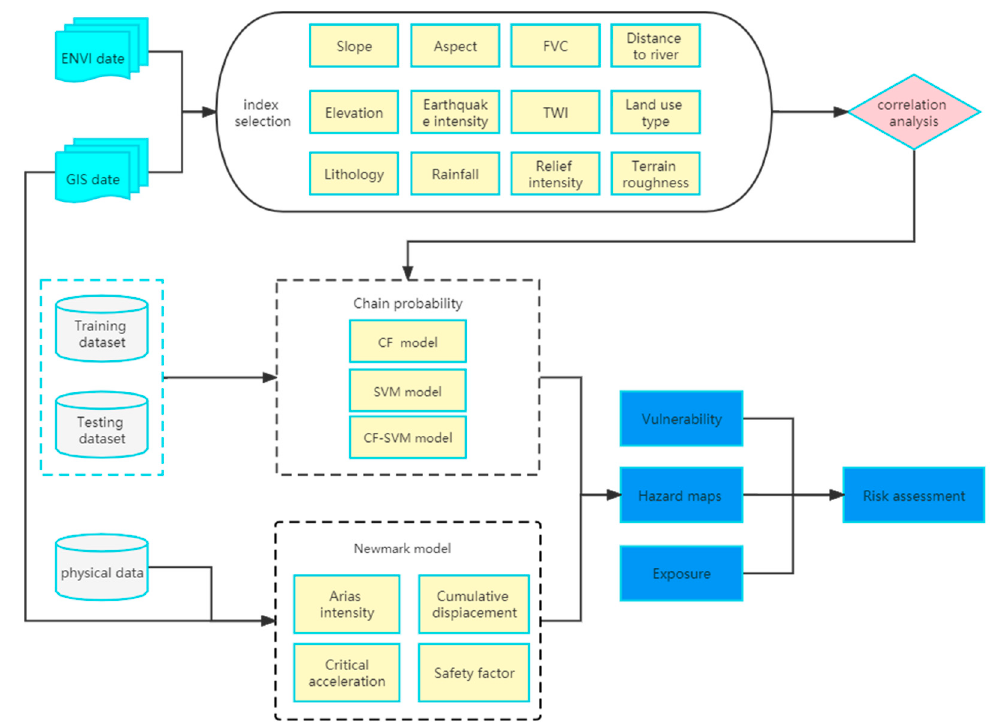
Figure 1. The risk assessment process of the earthquake disaster chain .